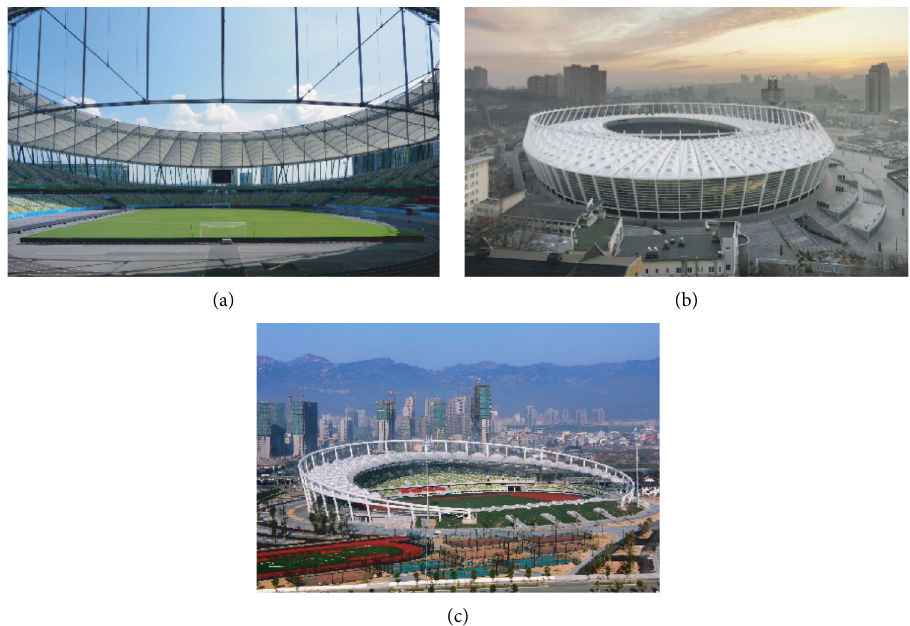
Figure 1: Typical projects of cable truss. (a) Shenzhen Bao’an stadium. (b) Ukraine National Sports Complex “Olympiysky”. (c) Yueqing